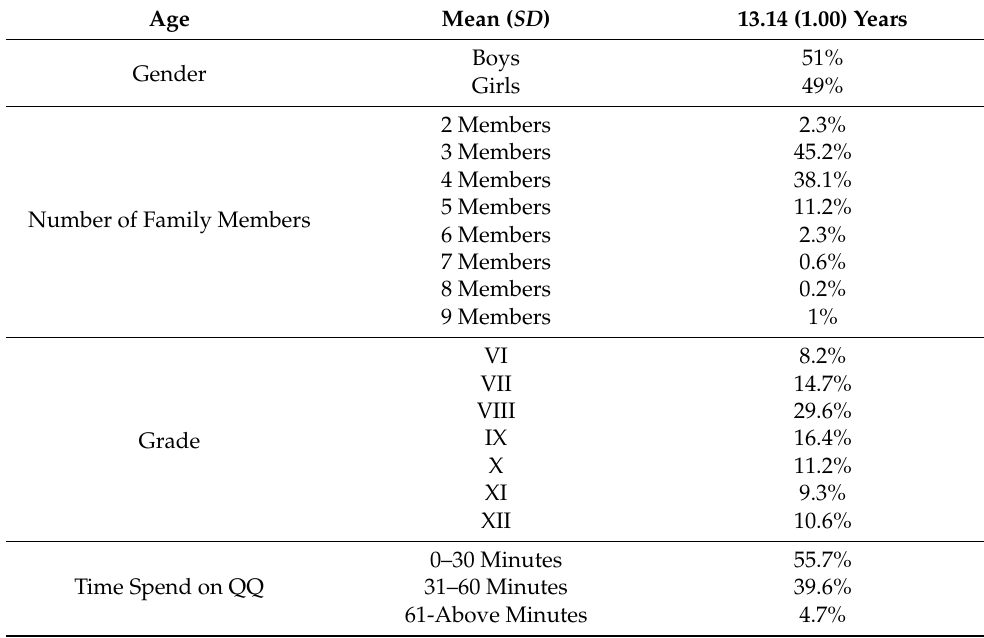
Table 1. Demographic distribution of